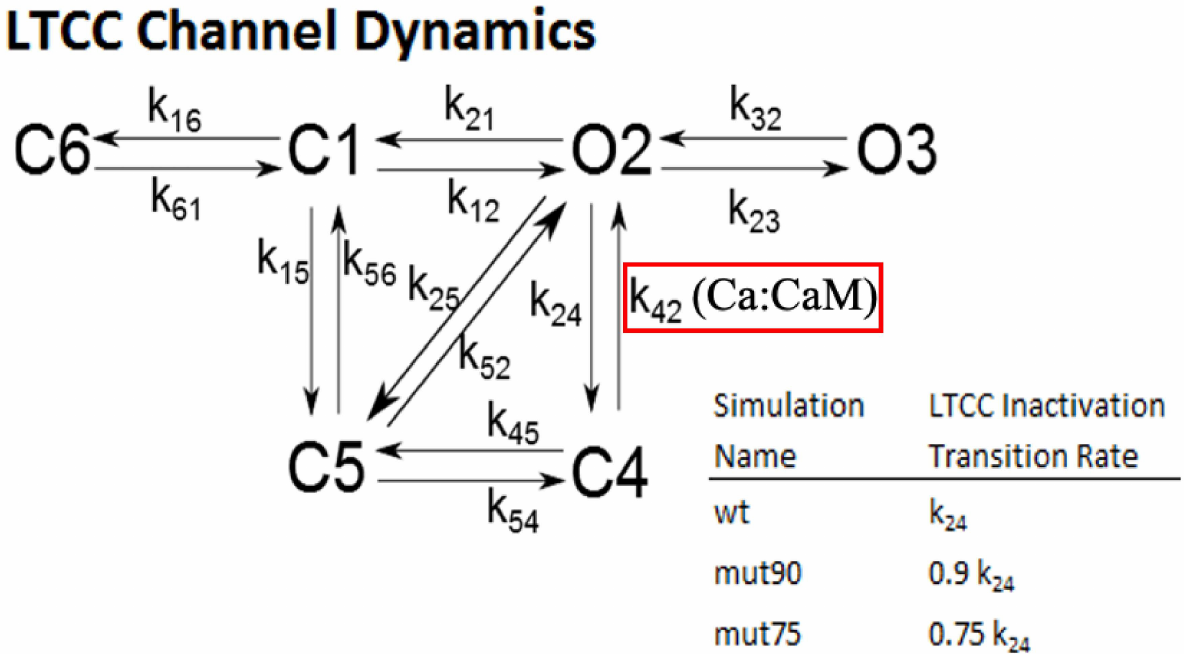
Figure 3. LCC 6 state model. The six states of a single L-type calcium channel (LCC). The transition from the closed state of C1 to the open state O2 is dependent on the transmembrane voltage. The channel inactivation to state C5 is dependent on voltage, but in the CRU, closing is dominated by the Ca : CaM -dependent transition to C4 (red box). By altering the transition rate to C4, subtle deficiencies in CaM inactivation can be modeled. The default value of k 24 is 8 s − 1 µ M − 1